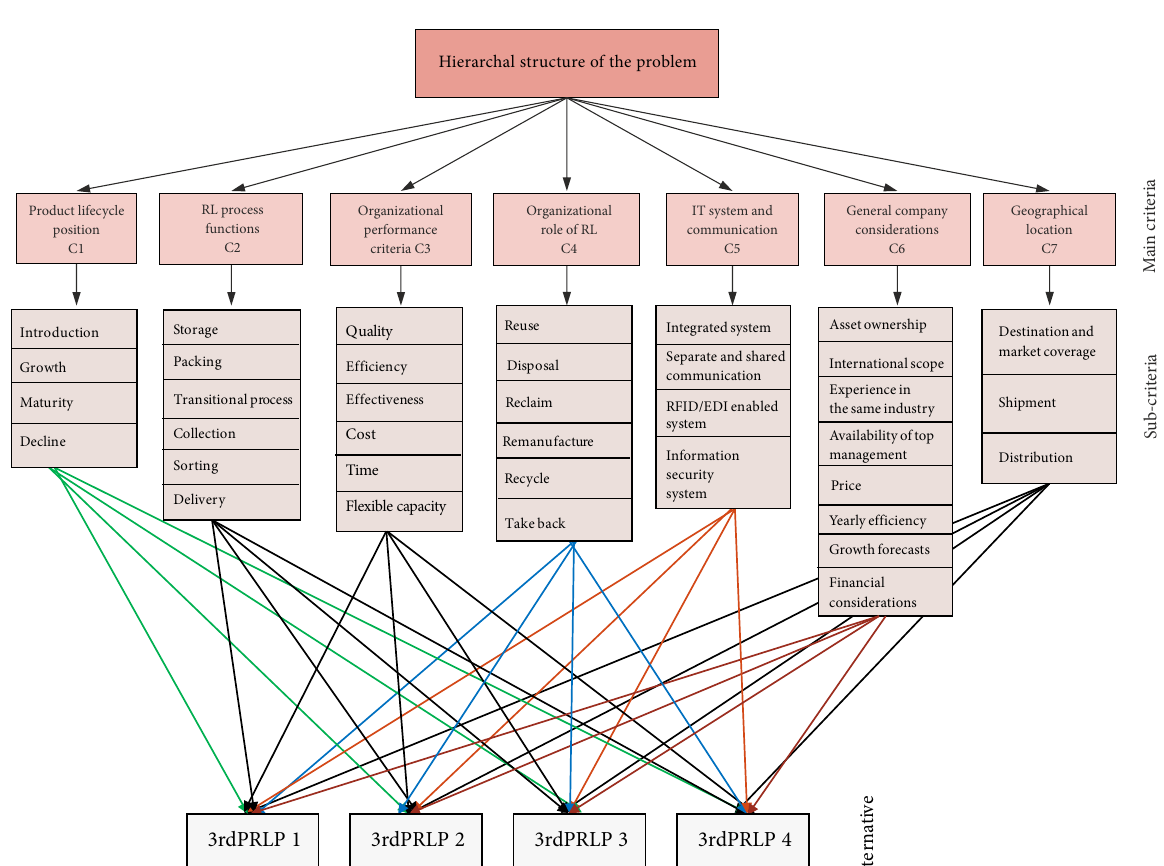
Figure 3. Hierarchy of the problem